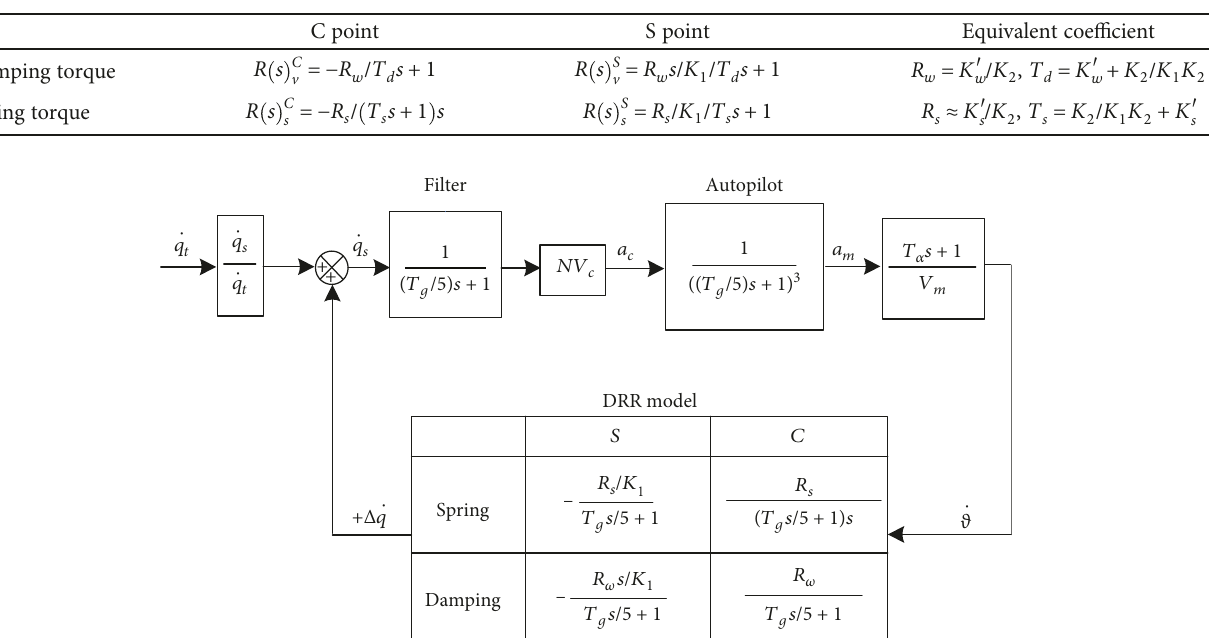
Table 2: First-order DRR transfer function of the seeker.